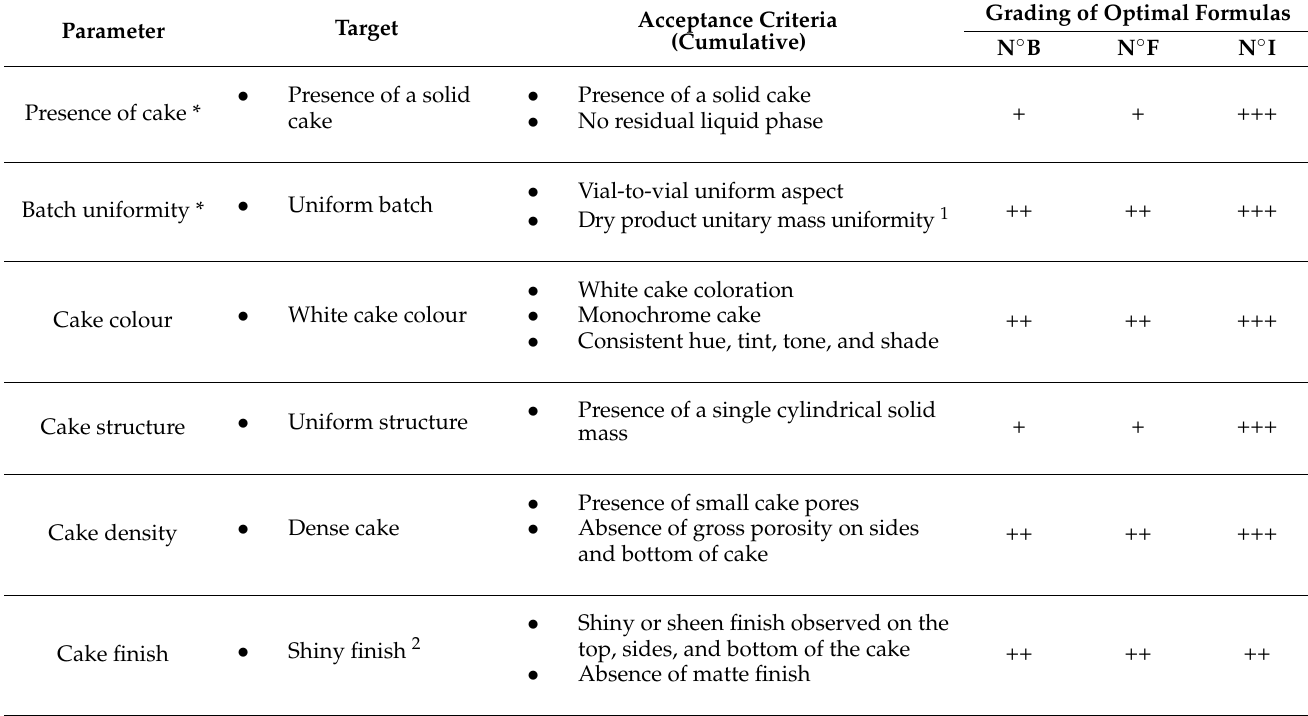
Table 2. Results of descriptive analysis, selected characterization testing, and corresponding grading for the obtained lyophilizates 48 h after lyophilization of dermal FPCs, formulated in adapted cryo- and lyo-protective solutions. Parameters considered as lyophilized product CQAs are evidenced with an * in the table hereunder. Formula I was experimentally assessed as optimal in the considered test conditions. Grading was performed using the abbreviated nomenclature presented hereafter. (–) = unsatisfactory, (+) = sub-optimal, (++) = satisfactory, (+++) = optimal. CQA, critical quality attribute; FPC, fibroblast progenitor cells; RH, relative humidity. Grading of Optimal Formulas Acceptance Criteria Parameter Target (Cumulative) N ◦ B N ◦ F N ◦